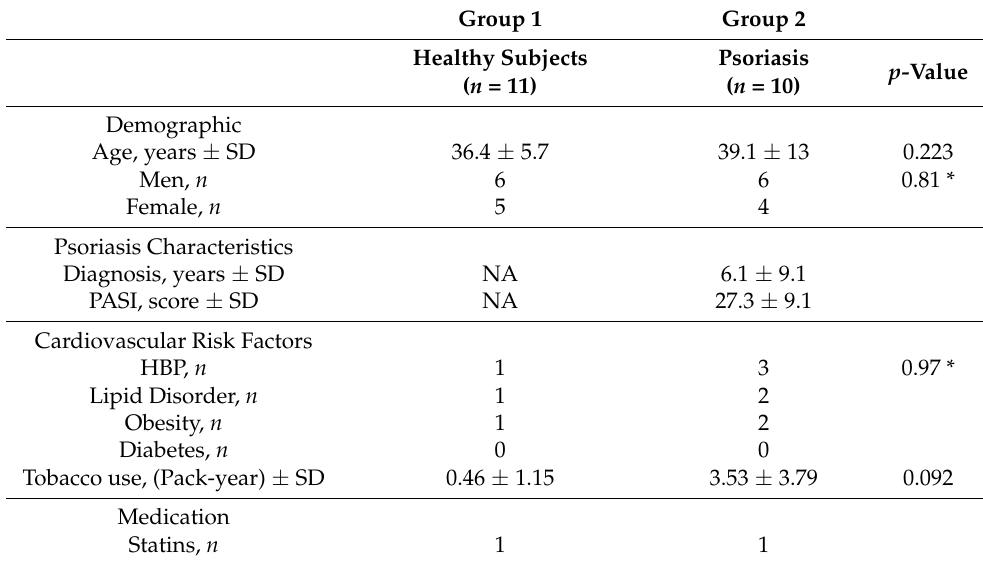
Table 1. Demographic and clinical